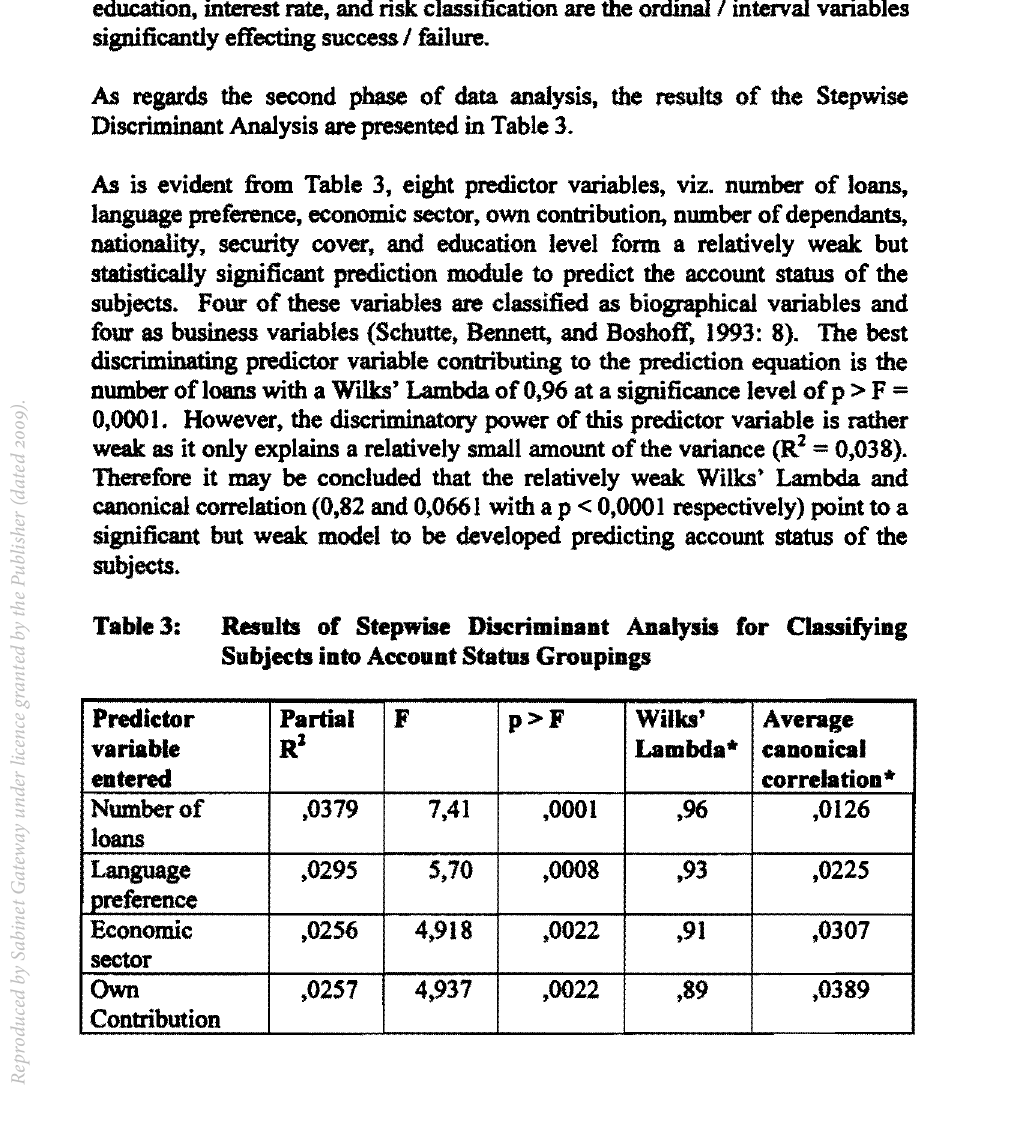
Results of Stepwise Discriminant Analysis for Classifying Subjects into Account Status